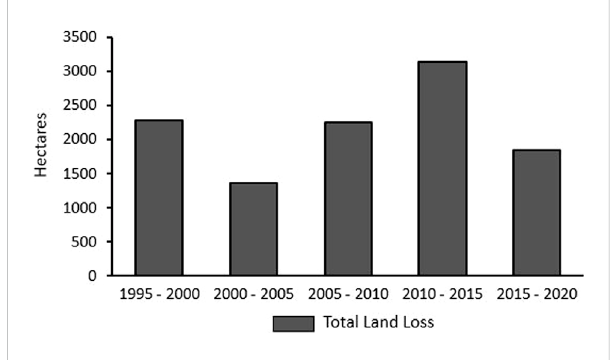
FIGURE 5 Total land loss in the studied area during 1995 –